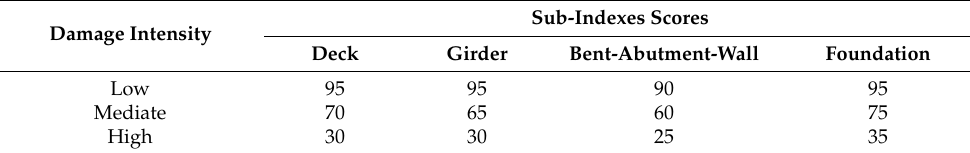
Table 10. Scores of sub-indexes in structural